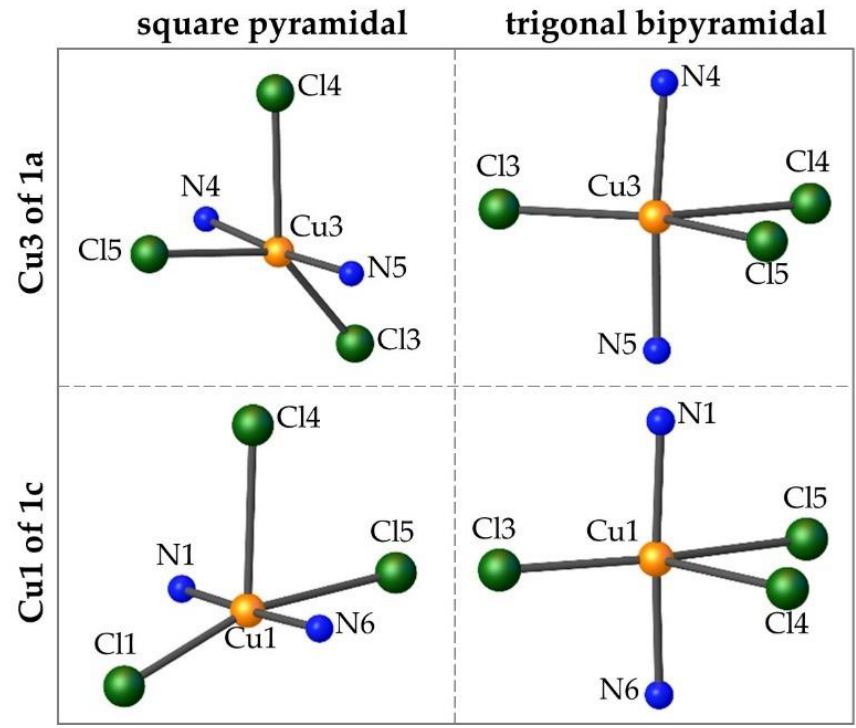
Figure 2. Comparison of the square pyramidal and trigonal bipyramidal geometries for the Cu3 of 1a ( τ = 0.57) and the Cu1 of 1c ( τ = 0.21).